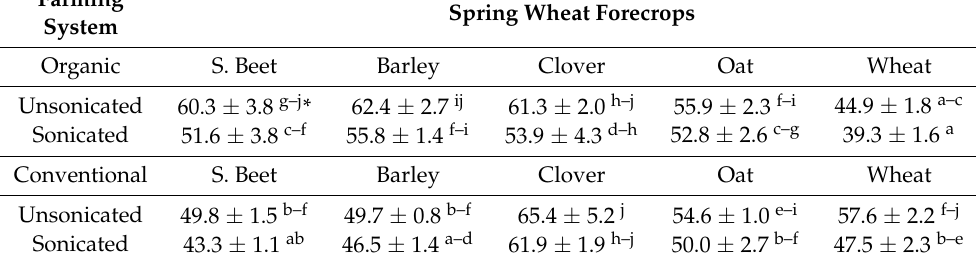
Table 12. Wheat gluten surface free energy SFE (mJ m − 2